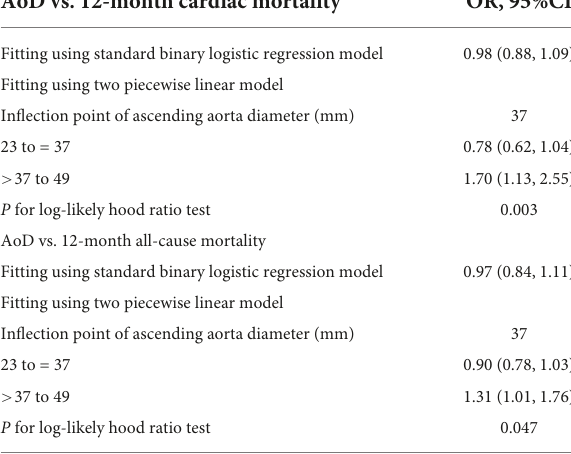
TABLE 3 Non-linearity addressing using two-piecewise linear